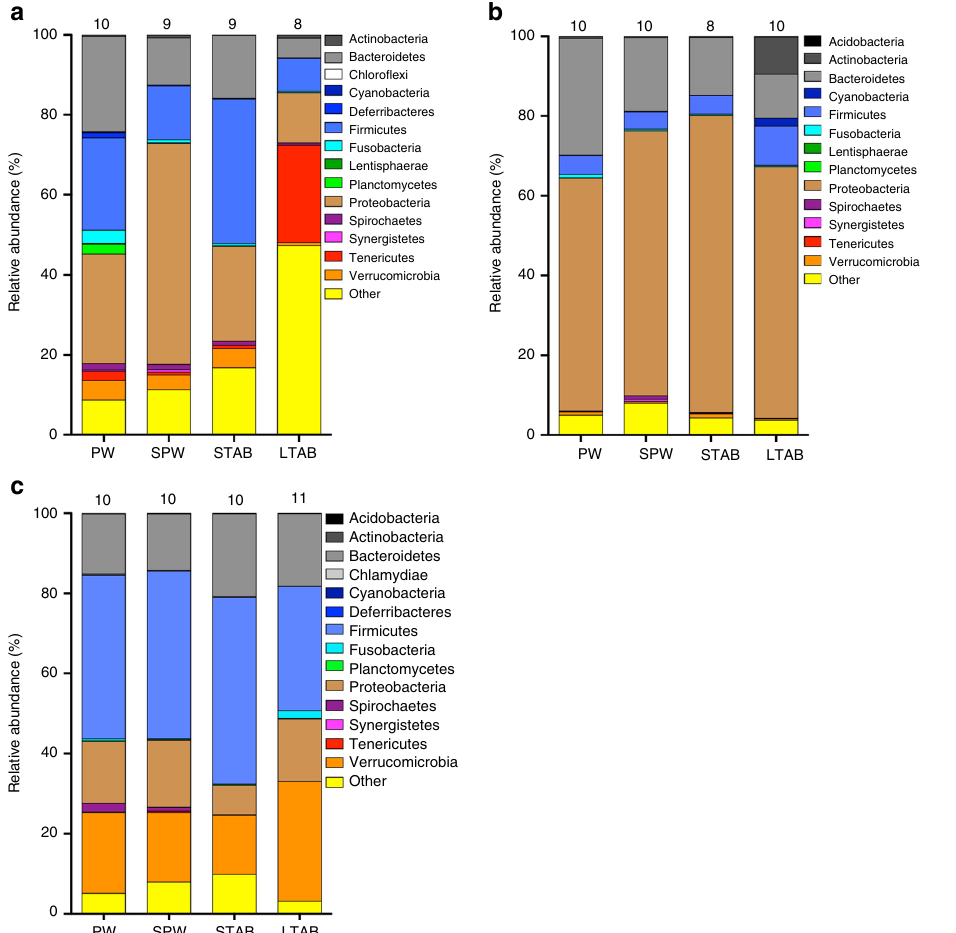
Fig. 3 Effect of juvenile water treatment on relative abundance of bacterial phyla. We analyzed the bacterial community of the gut a and skin b of juveniles, as well as that of the gut of adults c . Water treatments include pond water (PW), sterile pond water only (SPW), sterile pond water and short-term antibiotics (STAB), or sterile pond water and long-term antibiotics (LTAB). For juvenile guts a , mean relative abundance of phylum Proteobacteria was three times higher for individuals from sterile pond water only (GLM, χ 2 = 25.09, df = 3, P < 0.0001), Firmicutes was three times higher for individuals from pond water and short-term antibiotics ( χ 2 = 13.92, df = 3, P = 0.003), and Chloro fl exi was higher for individuals from pond water ( χ 2 = 25.11, df = 3, P < 0.0001) compared to individuals from the other treatments. For juvenile skin b , relative abundance of phylum Actinobacteria was 20 times higher for individuals from long-term antibiotic water compared to the other three treatments ( χ 2 = 70.42, df = 3, P < 0.0001) and Bacteroidetes was three times higher for individuals from pond water compared to individuals from long-term antibiotic water ( χ 2 = 11.89, df = 3, P = 0.008). For adult guts, relative abundance of phylum Actinobacteria was fi ve times higher for adults reared in sterile pond water compared to adults reared in long-term antibiotic water (GLMM, χ 2 = 10.05, df = 3, P = 0.02), Spirochaetes was generally higher in adults reared in pond water but was only signi fi cantly higher compared to adults reared in short- and long-term antibiotic water ( χ 2 = 14.39, df = 3, P = 0.002), and Cyanobacteria was lower for adults reared in long-term antibiotic water compared to adults reared in pond water and short-term antibiotic water ( χ 2 = 12.23, df = 3, P = 0.007). Numbers above the bars are the number of replicates (tanks) per treatment